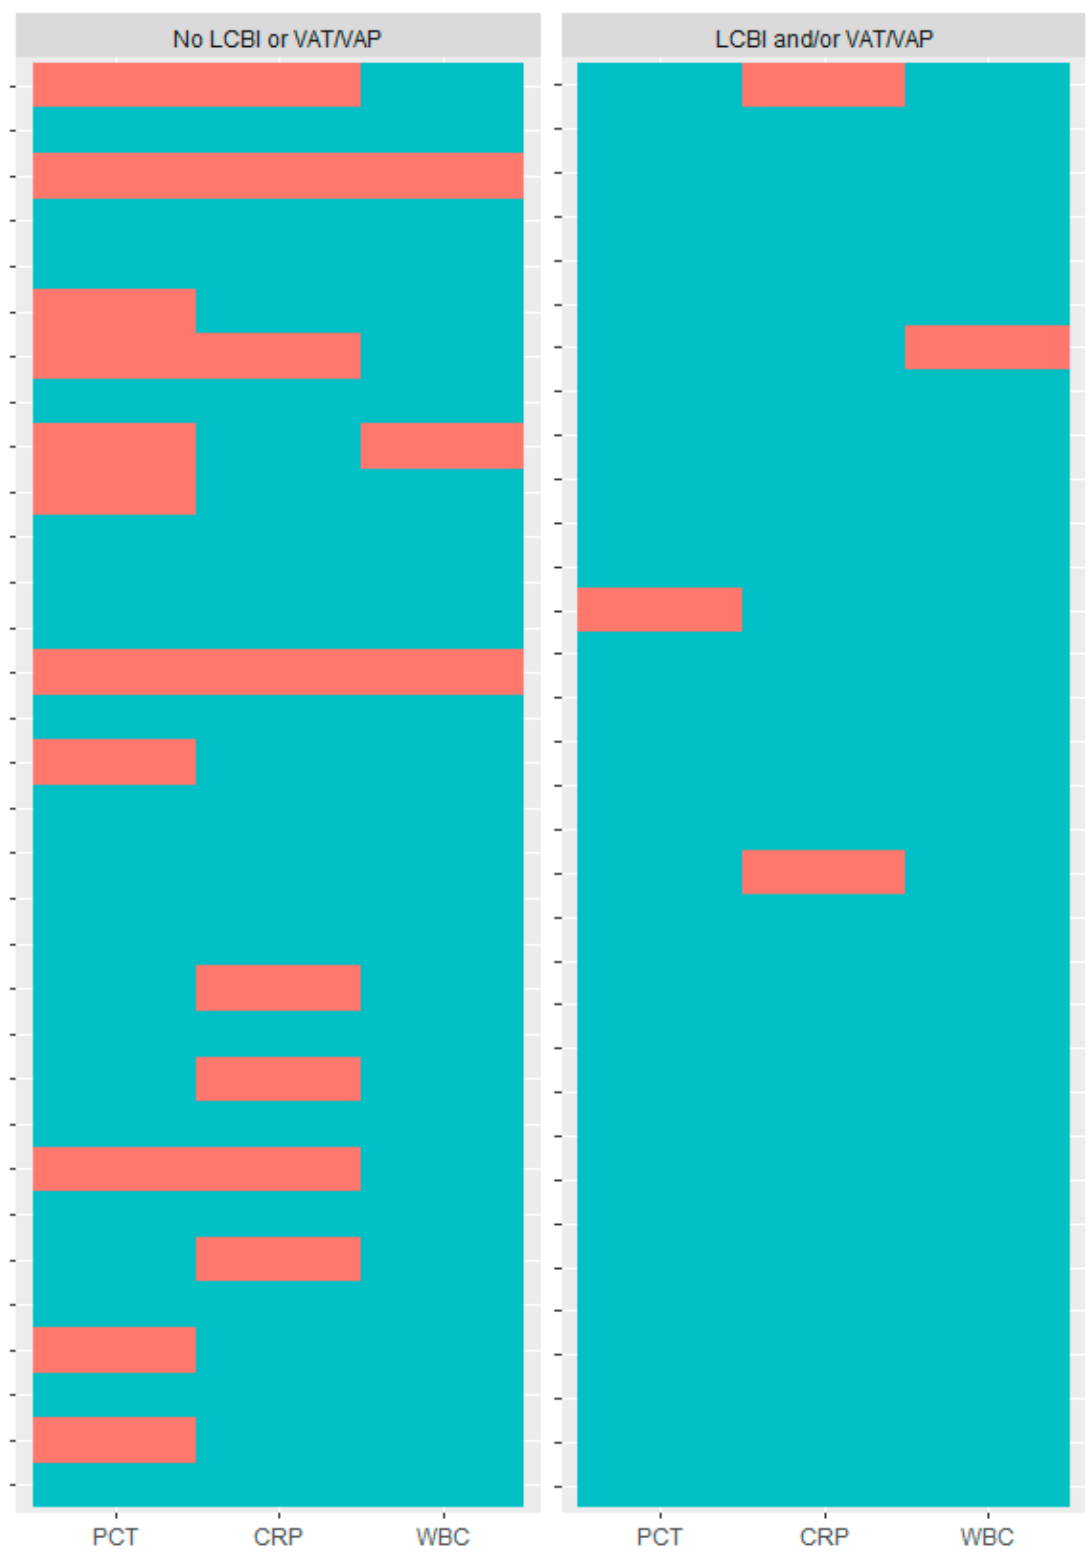
Figure 3. Heatmap of individual patients who experienced a rise in procalcitonin (PCT), C-reactive protein (CRP) and white blood cell count (WBC) in the context of confirmed ventilator-associated pneumonia/tracheobronchitis (VAP/VAT) or laboratory-confirmed bloodstream infection (LCBI). Green = biomarker rise; red = no biomarker rise.